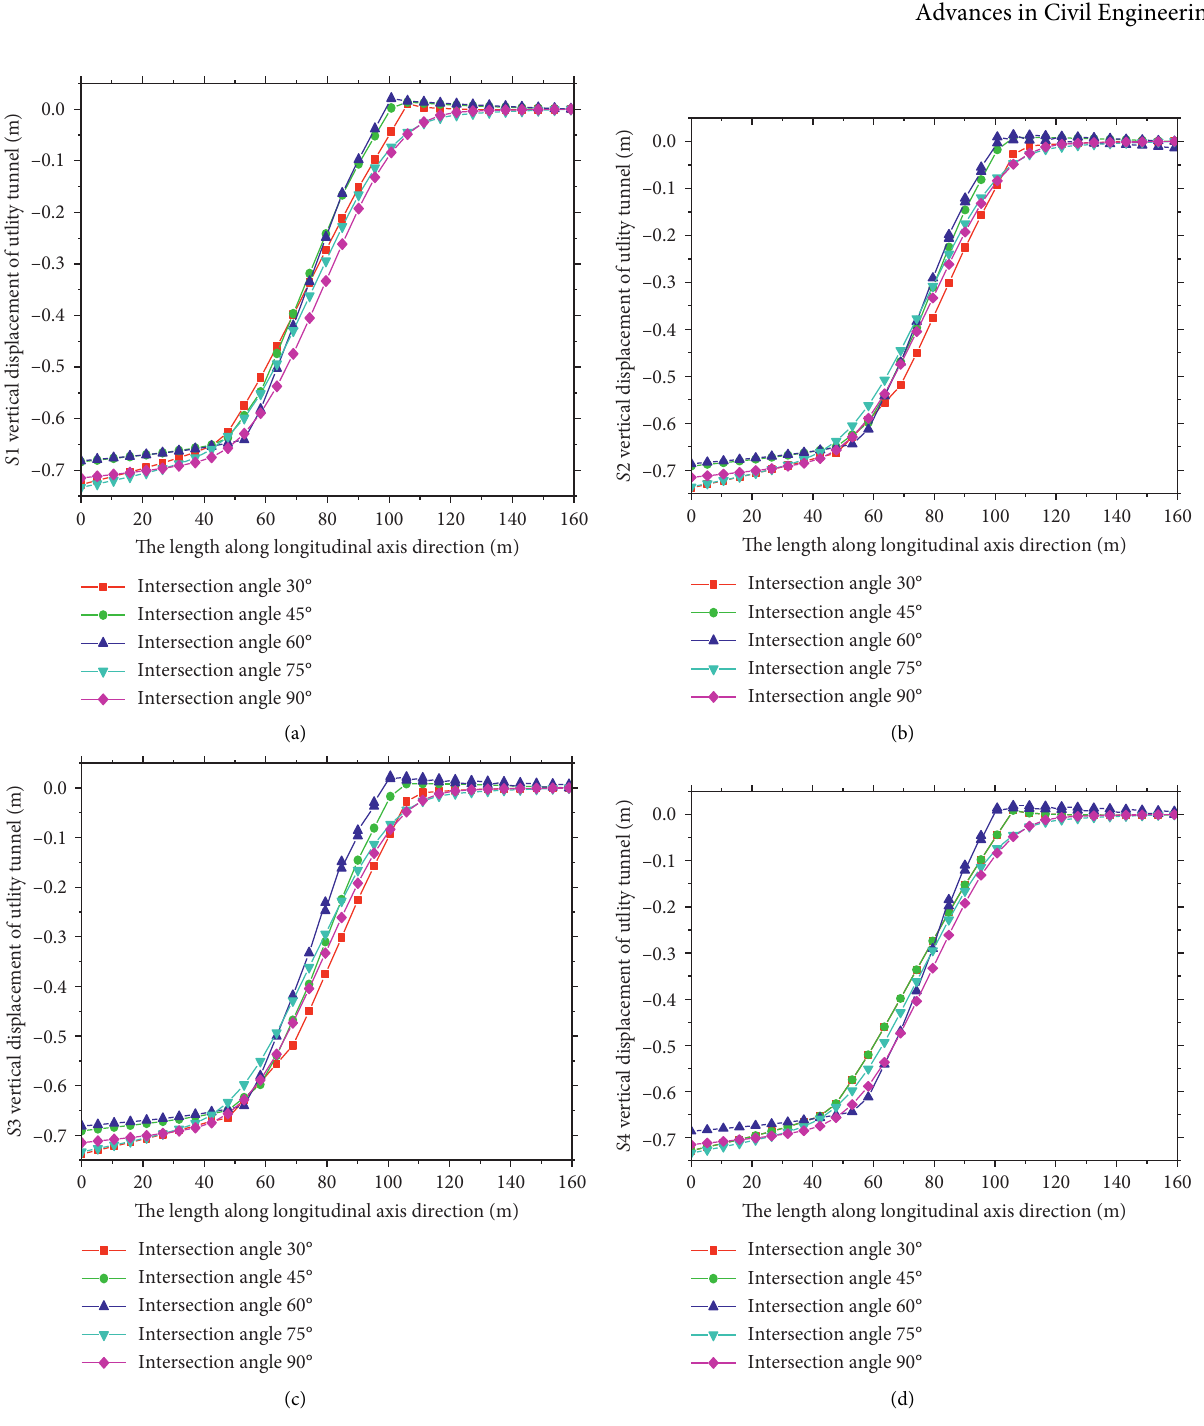
Figure 7: Horizontal displacement of each surveying line. (a) The horizontal displacement of surveying line 1. (b) The horizontal dis- placement of surveying line 2. (c) The horizontal displacement of surveying line 3. (d) The horizontal displacement of surveying line